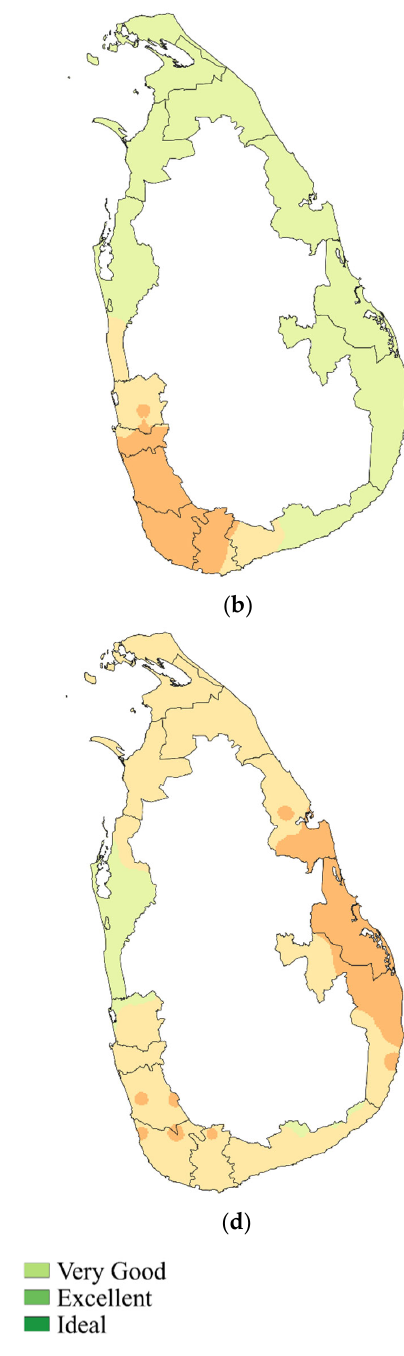
Figure 3. Spatial distribution of HCI Beach scores for 2010–2018: ( a ) For 1st Inter monsoon; ( b ) For Southwest monsoon; ( c ) For 2nd Inter monsoon; ( d ) For Northeast monsoon. Table 1. HCI Beach values under measured climatic data (2010–2018).